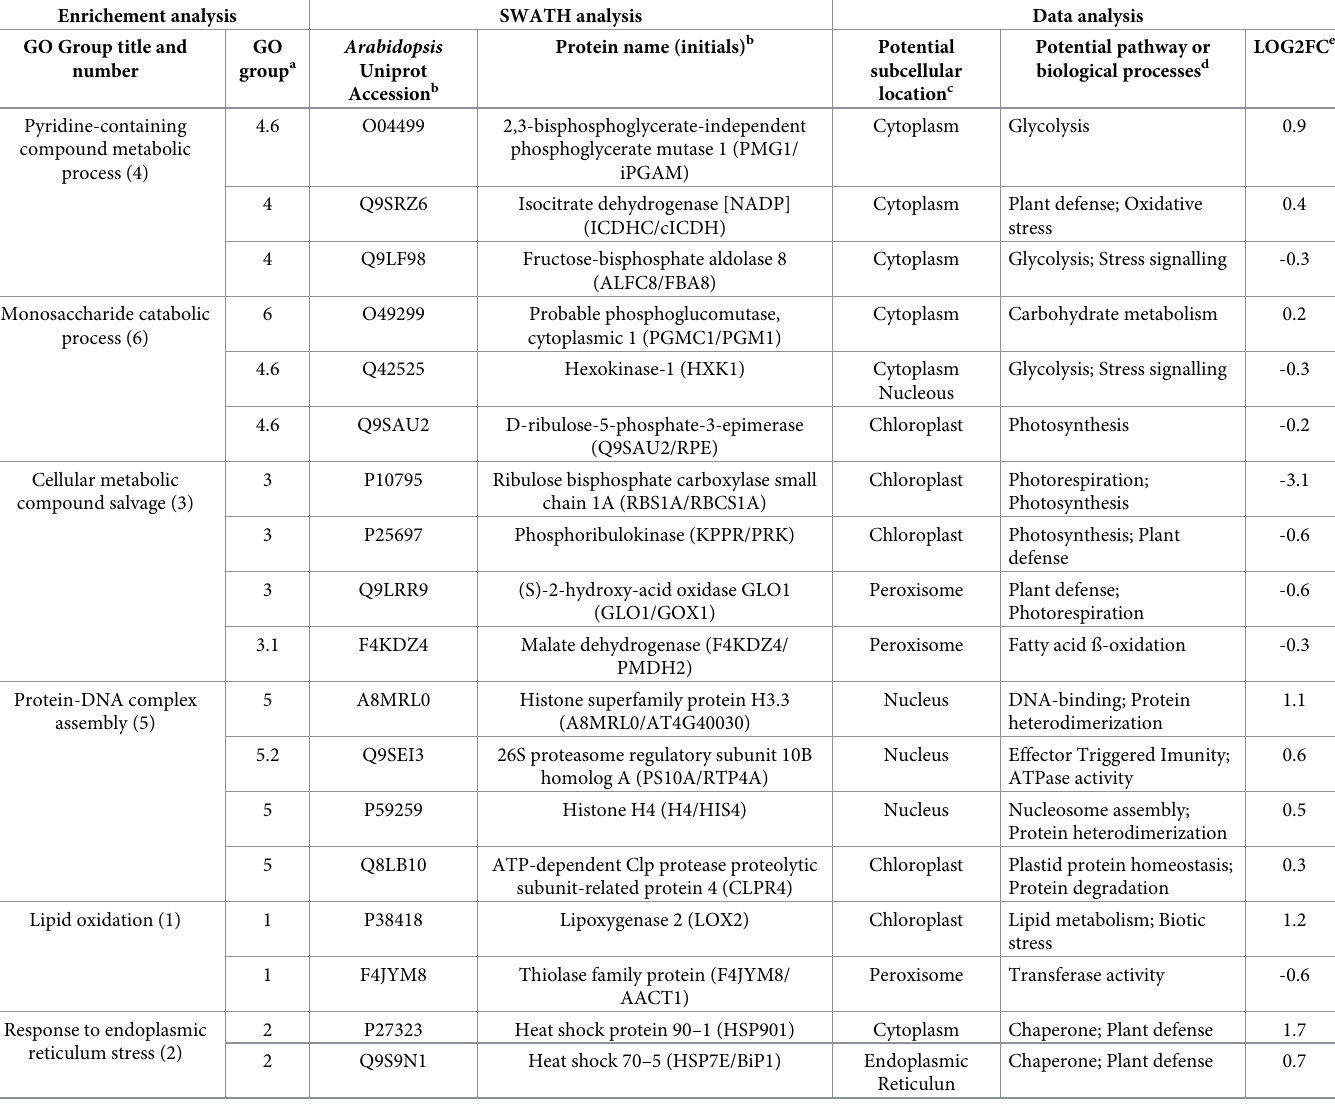
Table 4. Proteins from the selected dataset assigned to Biological process GO terms with the highest enrichment scores. Enrichement